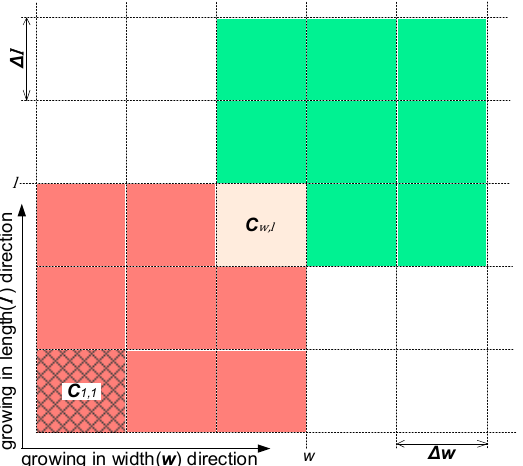
Figure 11. The discretization of particle width and length at time 𝑡 .